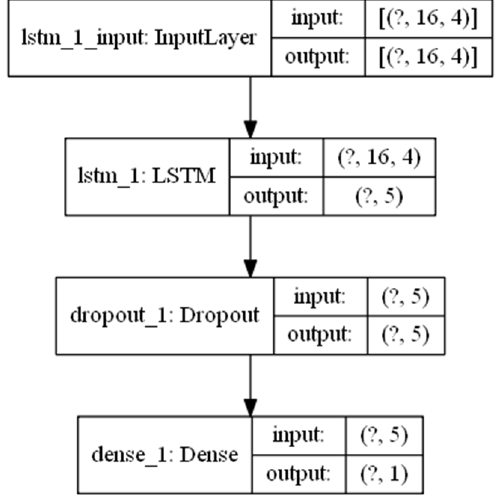
Figure 8. Single LSTM layer RNN model parameters.